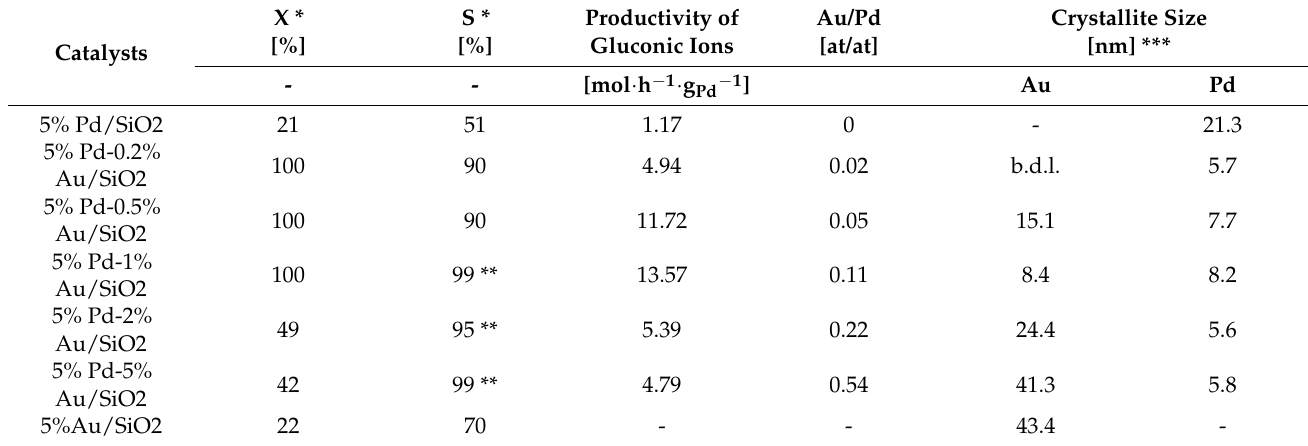
Table 1. Size of palladium and gold crystallites calculated based on XRD measurements in Pd-Au/SiO 2 bimetallic catalysts, relative to activity, selectivity, and productivity. Reaction conditions: T = 60 ◦ C, m cat = 1g, C 0 = 1 mol · dm − 3 , pH = 9, V O2 = 1 dm 3 · min − 1 .